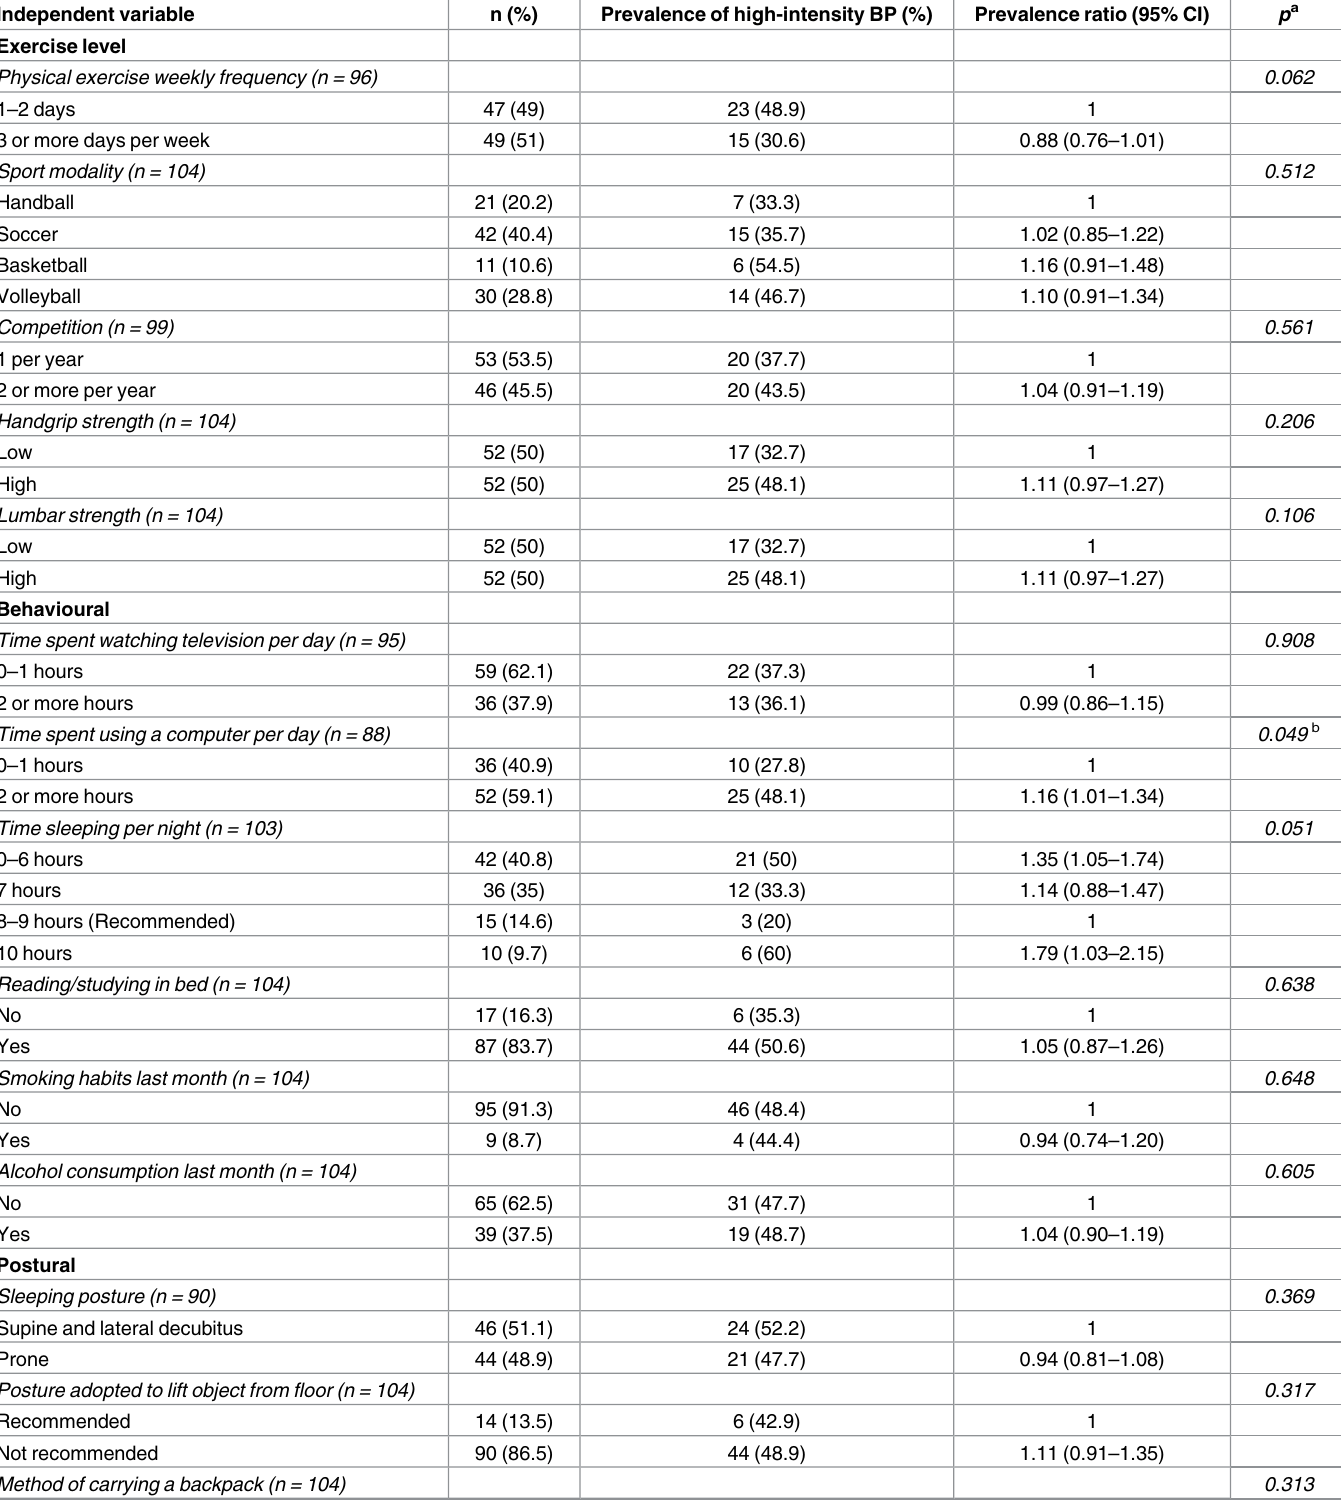
Table 3. Association ( χ 2 ) and prevalence ratio of back pain intensity with independent variables (exerciselevel, behavioural, and